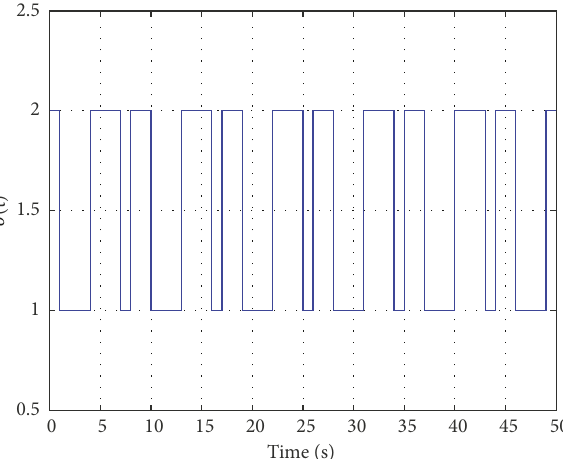
Figure 2: Trajectory of tracking error 𝑒 1 (𝑡) .